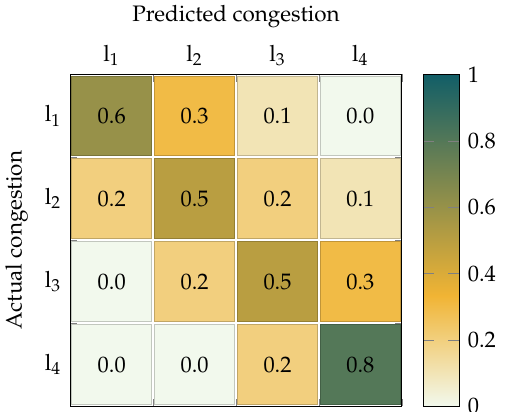
Figure 10. Confusion matrix of the hierarchical clustering for a scenario with data rate of 30 Mbps and distance of 40